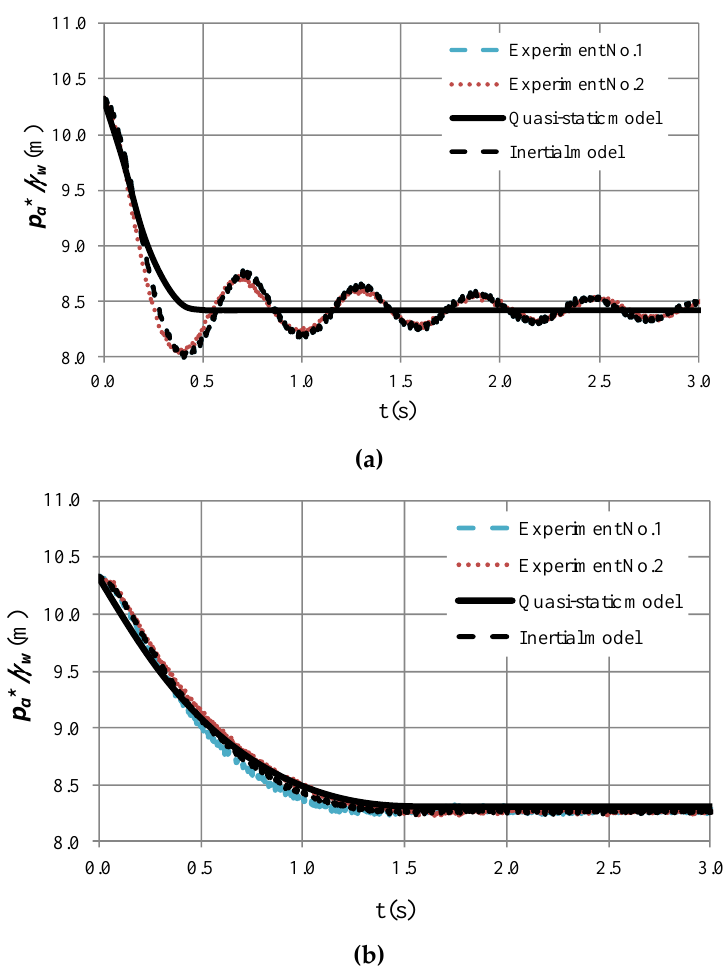
Figure 6. Comparison of air pocket pressure patterns between the quasi-static flow and inertial models: ( a ) Run No. 1; ( b ) Run No. 11.